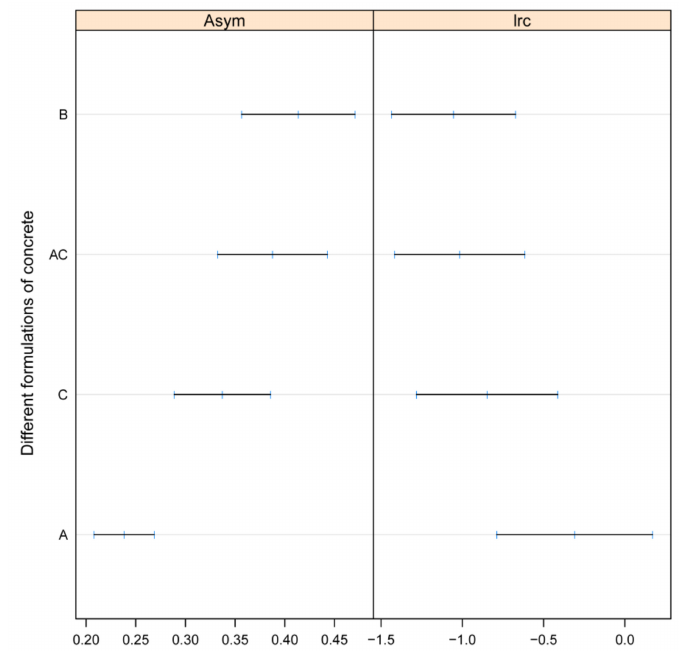
Figure 13. Ninety-five percent confidence intervals for the parameters of the asymptotic models fitted to the concrete mass loss as a function of time, for each concrete formulation. The A formulation is the treatment where the 20 wt.% of sand is replaced by mussel shells, the B level is the control treatment, in the C treatment, the 10 wt.% of cement has been replaced, whereas in the AC treatment, we replace the 10 wt.% of sand and the 5 wt.% of cement.